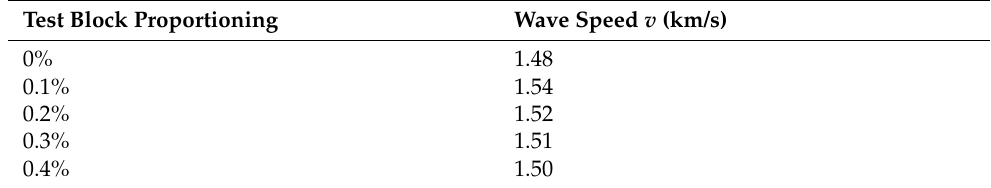
Table 5. Ultrasonic test results of test blocks before freeze–thaw cycles.